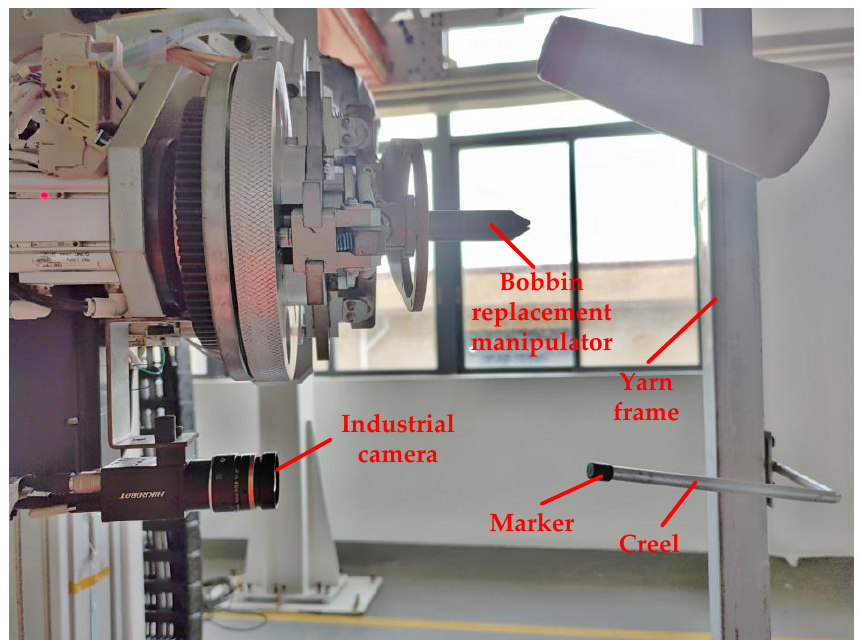
Figure 2. This is the physical drawing of creel visual positioning system.